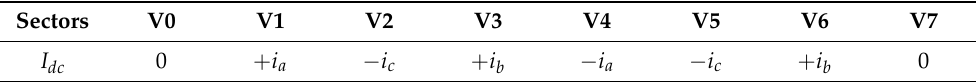
Table 2. Current flow paths table.